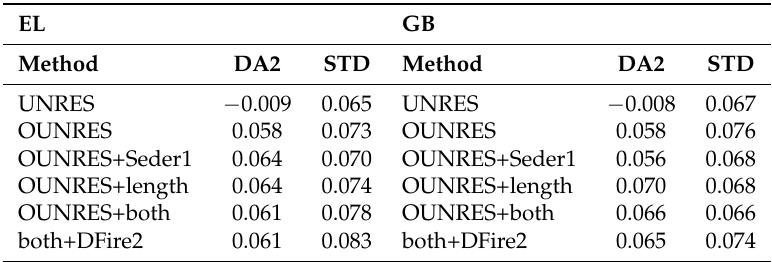
Table 7. Second Directional Accuracy